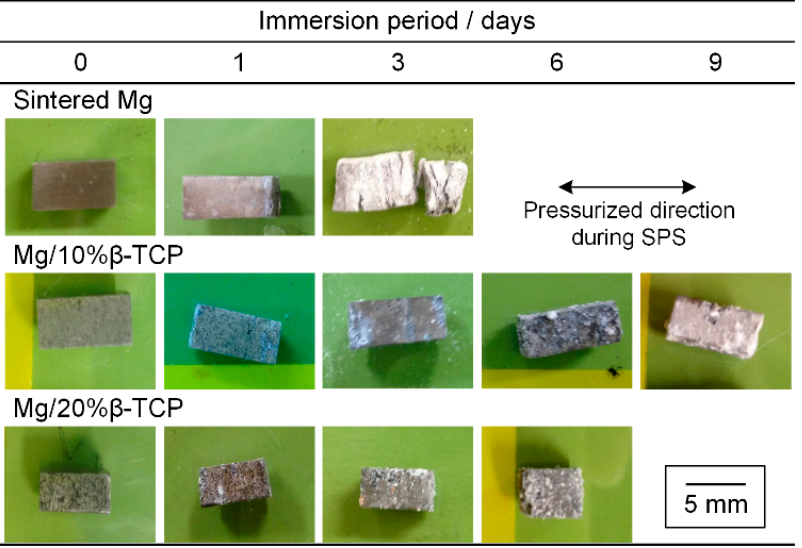
Figure 3. Photographs of specimens before and after immersion for each prescribed period.